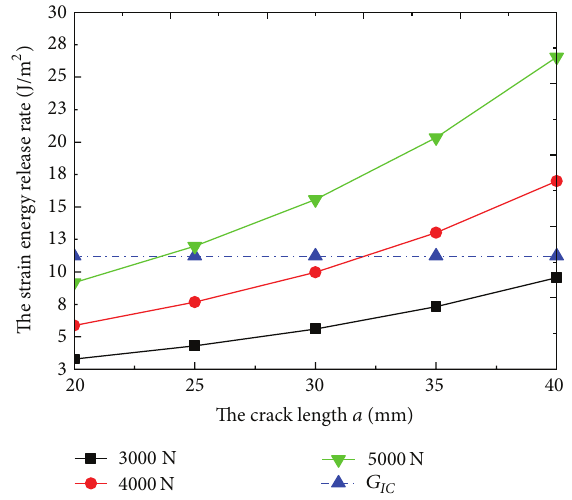
Figure 6: The comparison of SERR between the different load and the critical case.